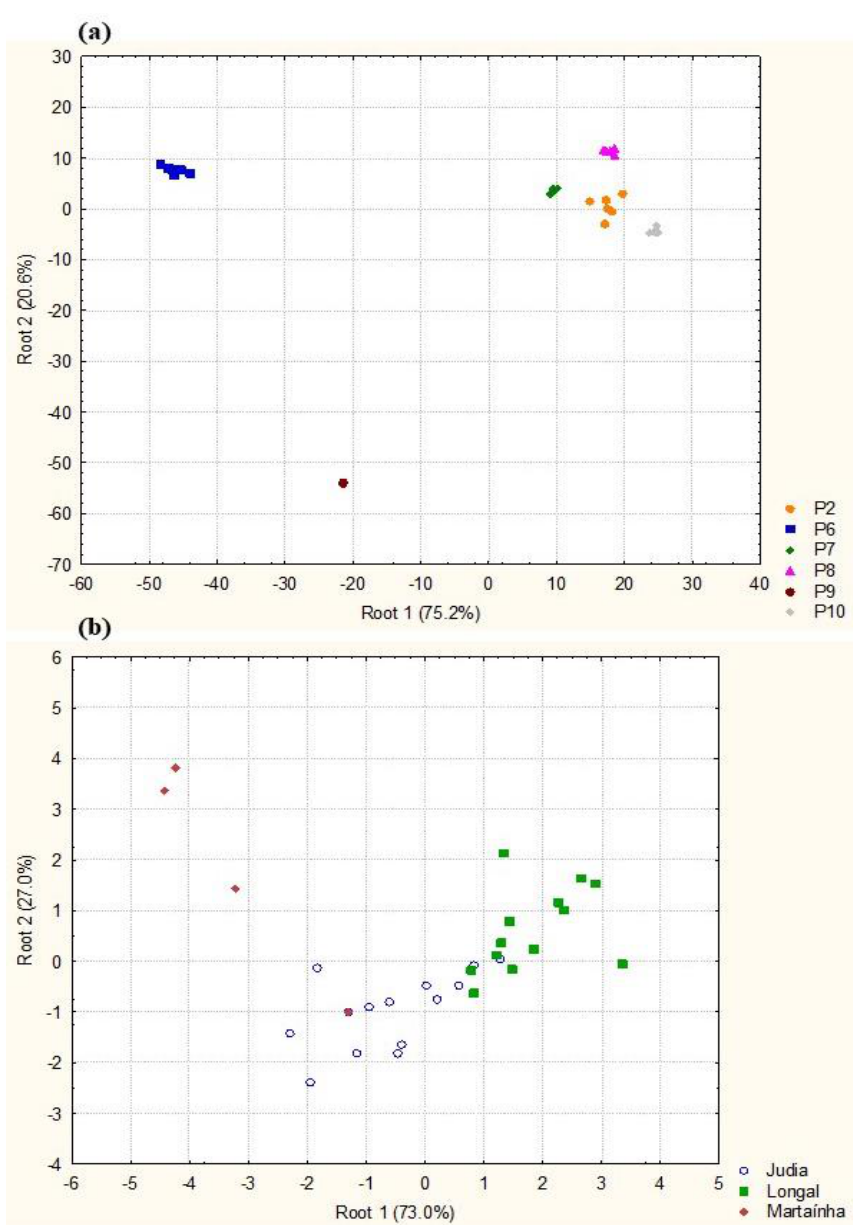
Figure 9. Diagrams for the first two roots obtained by MDA of mold species composition in processing stages ( a ) and chestnut varieties ( b ). P2—sterilized chestnuts; P6—unsterilized chestnuts in reception; P7, P8, P9—unsterilized chestnuts after storage (15, 30 and 45 days, respectively); P10—sterilized chestnuts rejected by